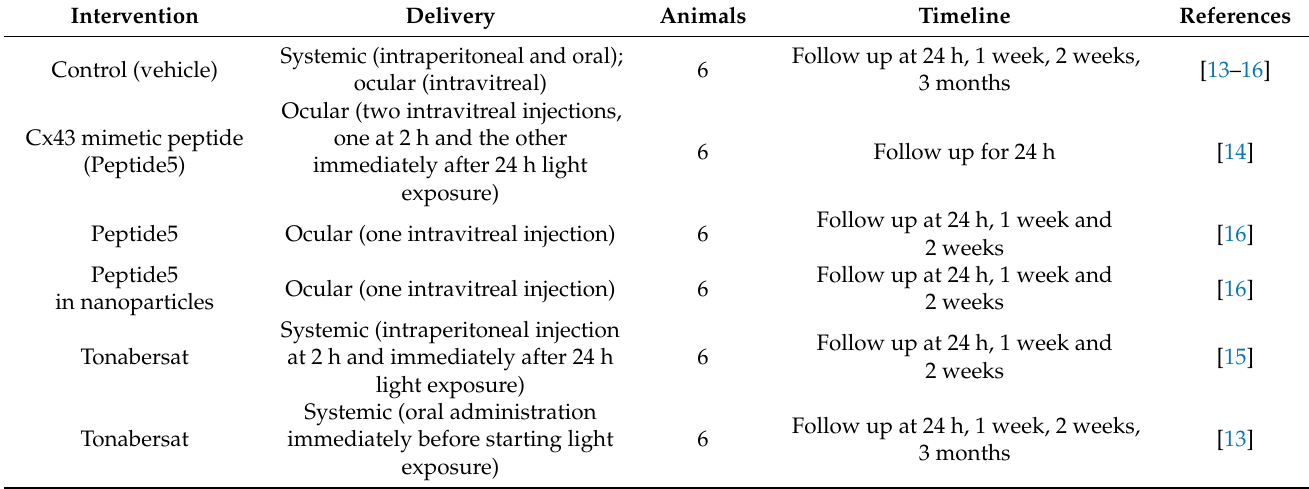
Table 1. Summary of our published data reporting a therapeutic effect in the light-damaged rat model after intervention with Cx43 hemichannel blockers (tonabersat or Peptide5) with specific delivery